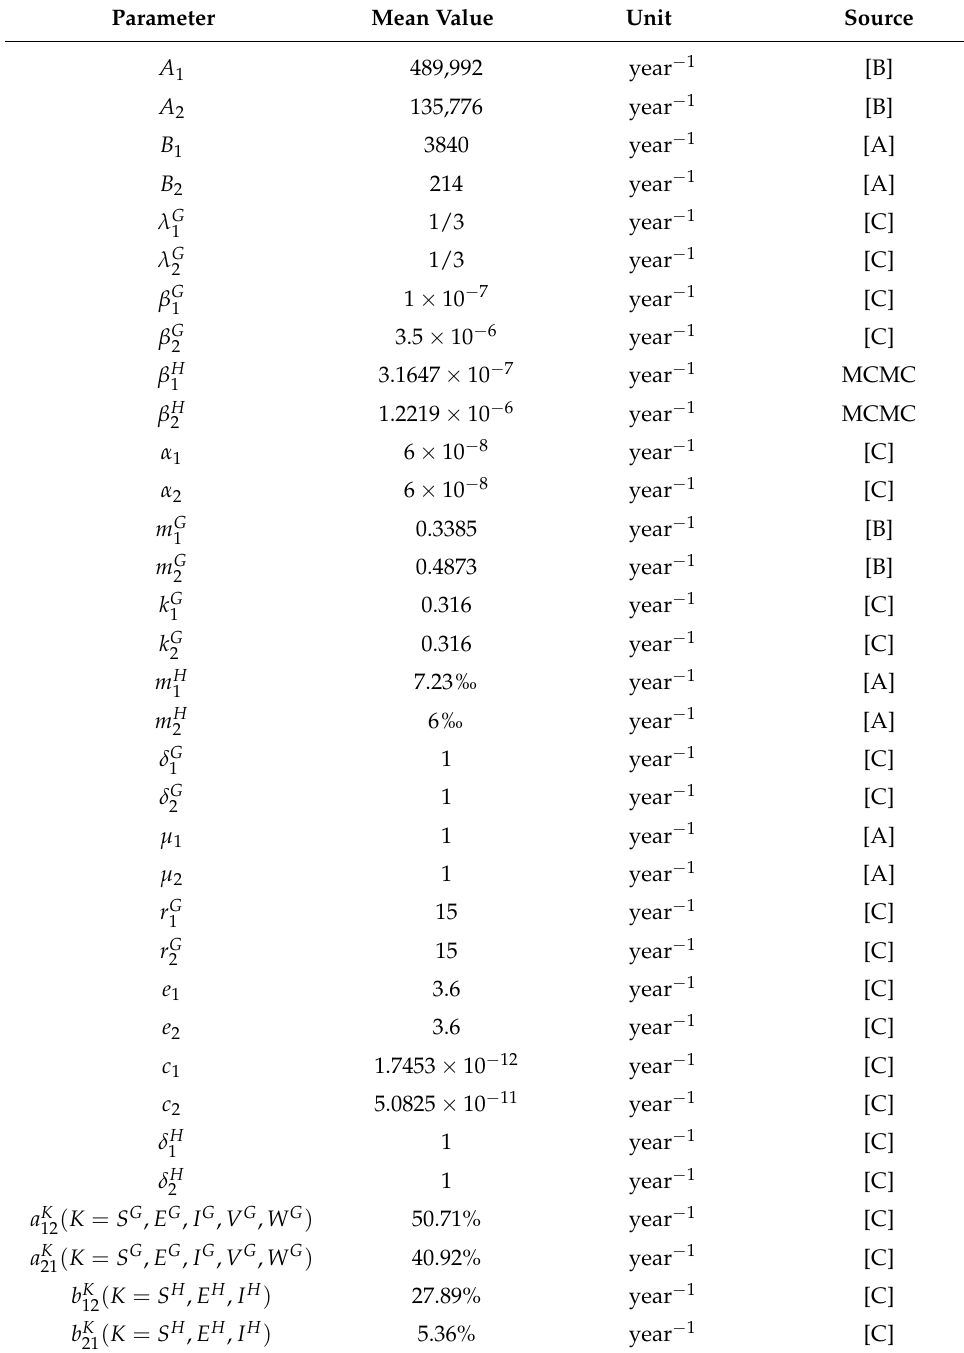
Table 2. Definitions and values of variables and